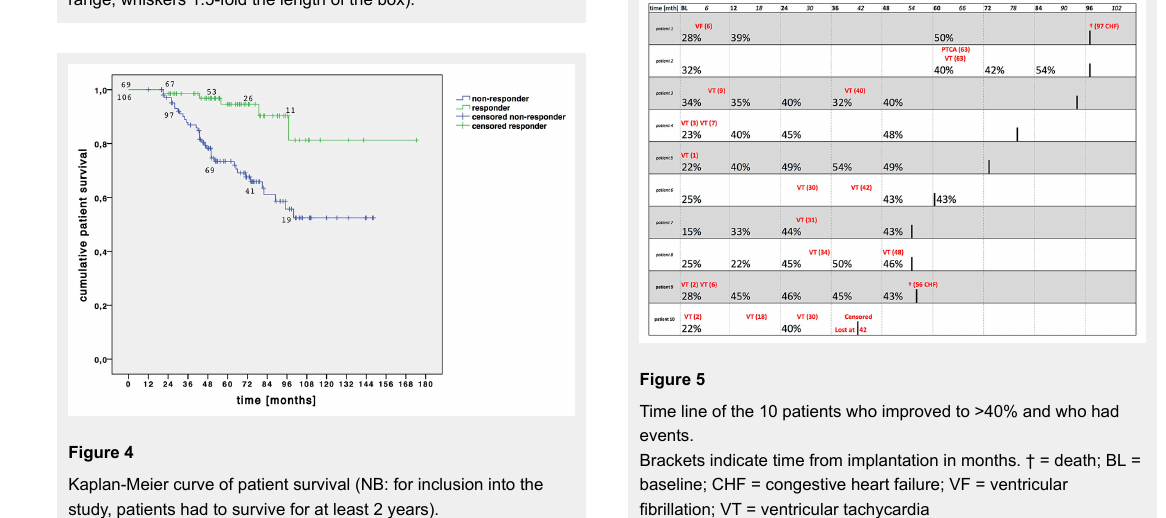
Changes in ejection fraction during long-term follow-up in patients without improvement to >40% (boxes indicate the interquartile range, whiskers 1.5-fold the length of the box).